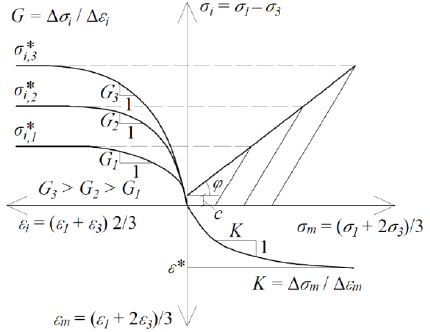
Figure 1. Schematic representation of the results of standard triaxial tests of soils in the kinematic mode of loading ( ε 1 = const or σ 1 = const) along the fracture path.